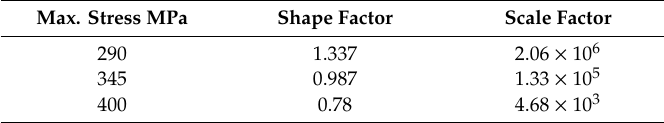
Figure 2. Schematic of the origin of the strength-life equal-rank assumption (SLERA). Table 1. The Weibull parameters for fatigue